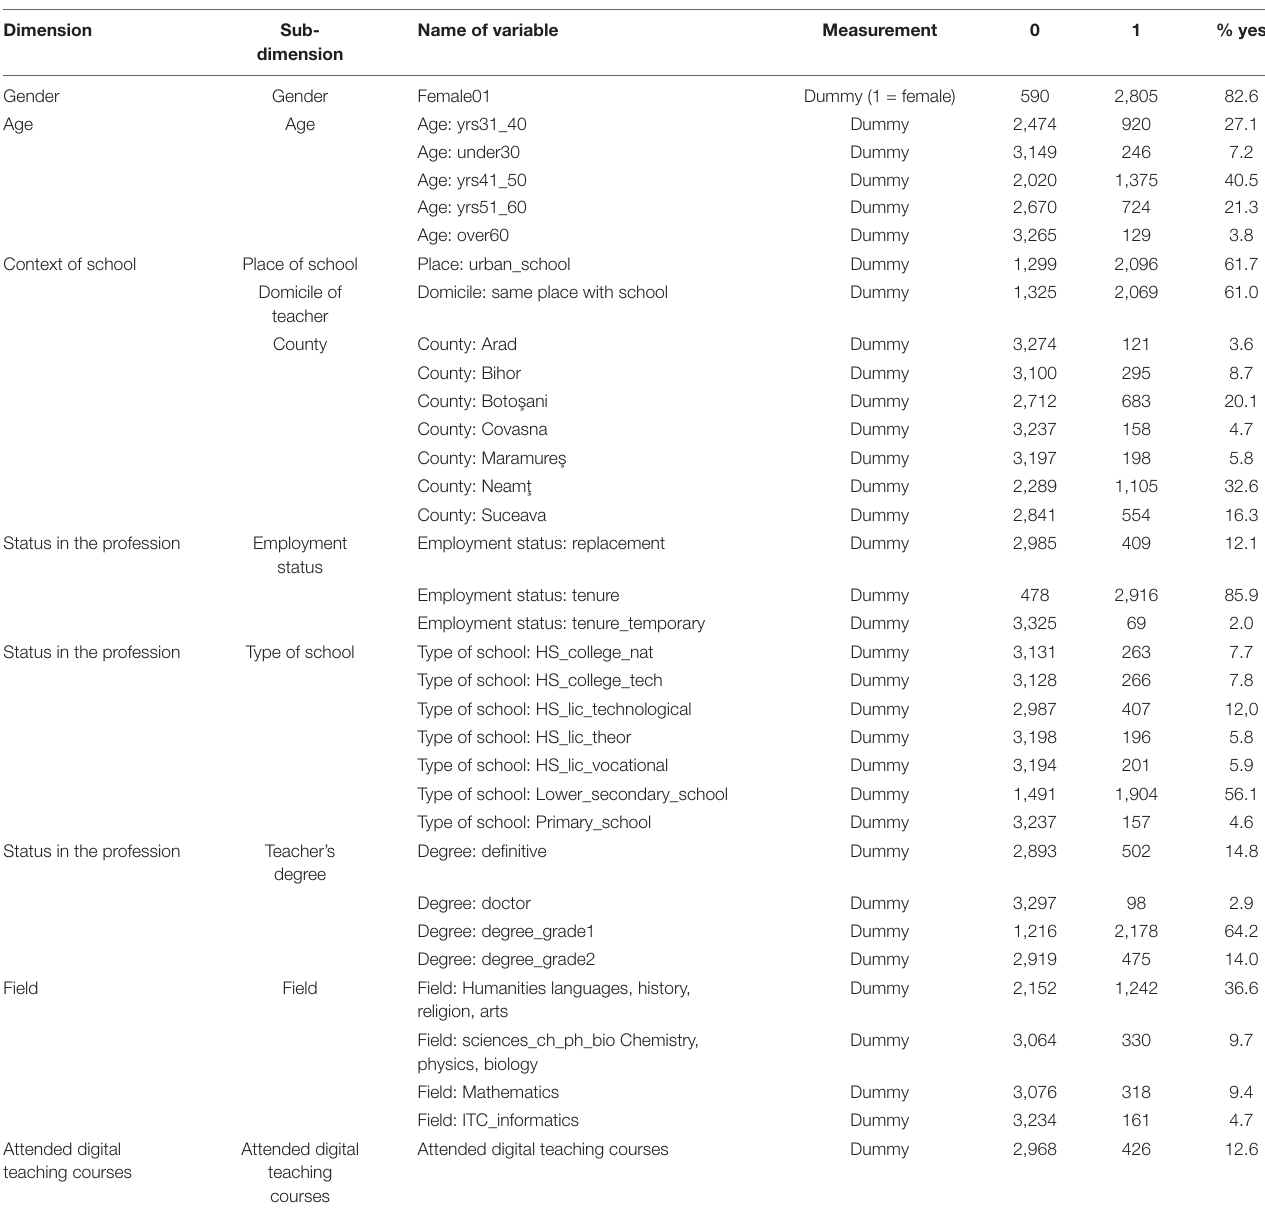
TABLE 1 | Independent variables in hierarchical linear regression. Dimension Sub-